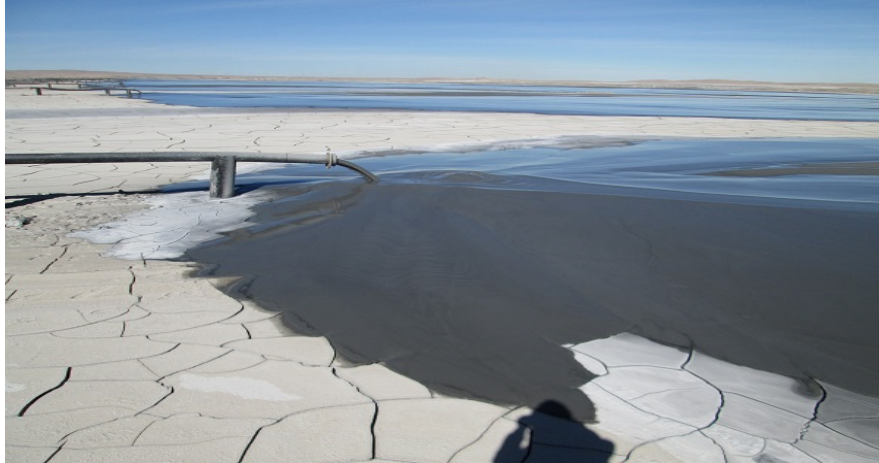
Figure 7. Thickened Tailings Technology—Esperanza TSF Centinela Mine Chile [11].